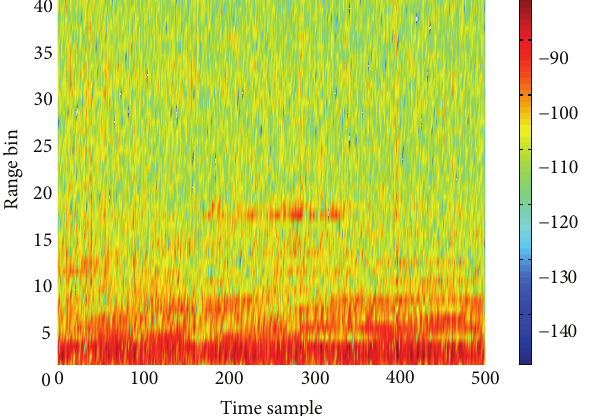
Figure 8: Range spectrum after clutter and RFI mitigation.